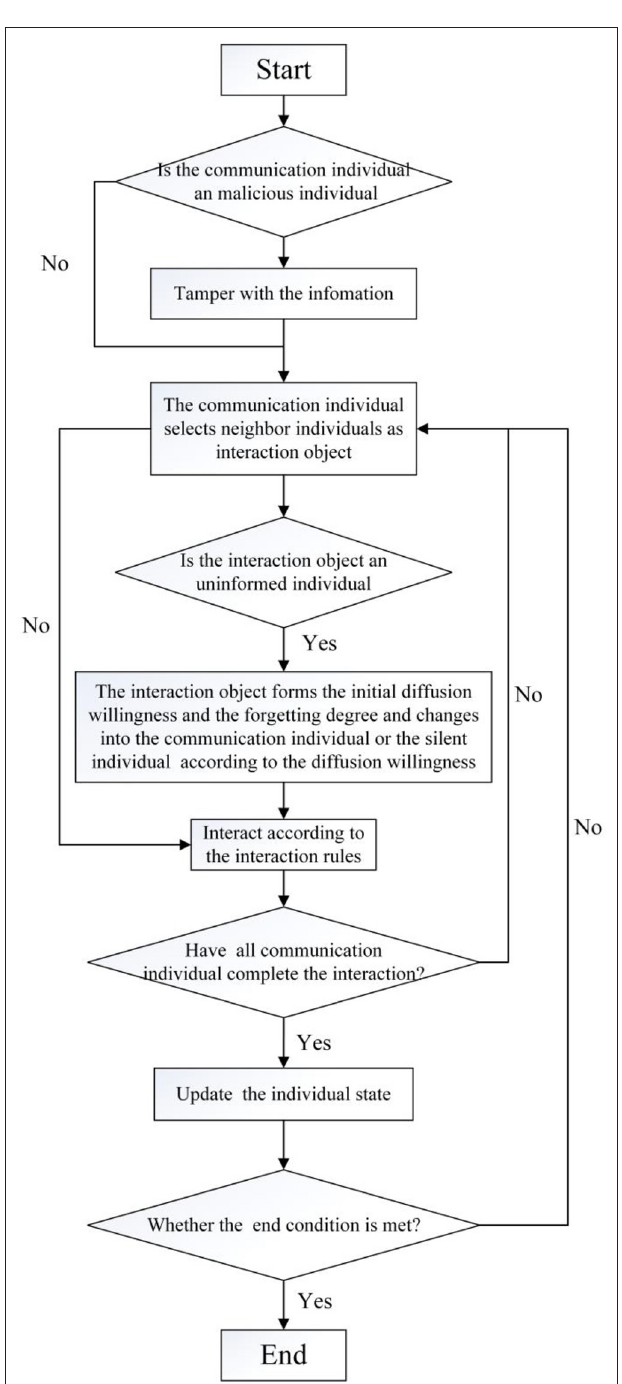
FIGURE 5 | Simulation flow of the formation and diffusion of